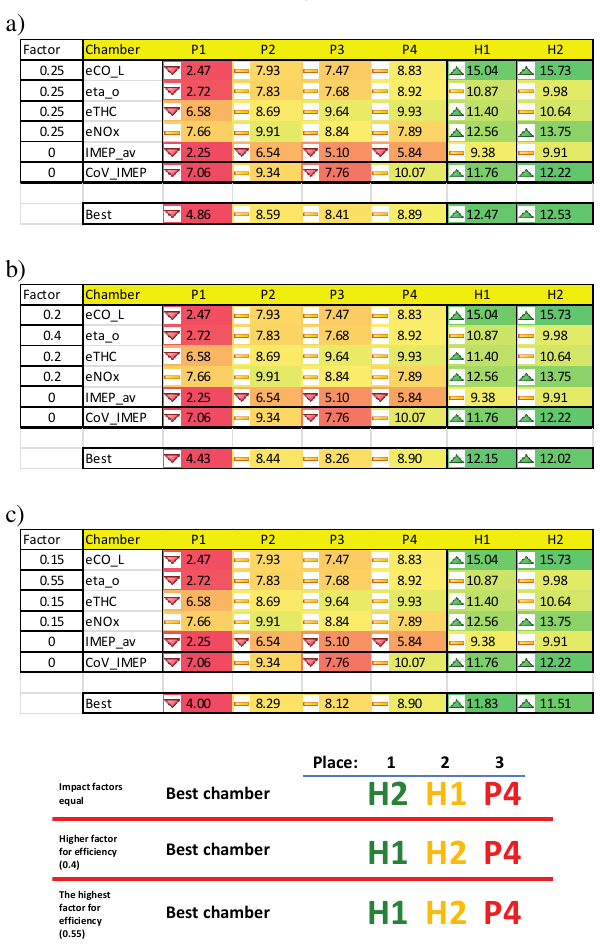
Fig. 19. Results of the search for the best configuration of the combustion system for different impact factors assigned to different coefficients (1 st approach)